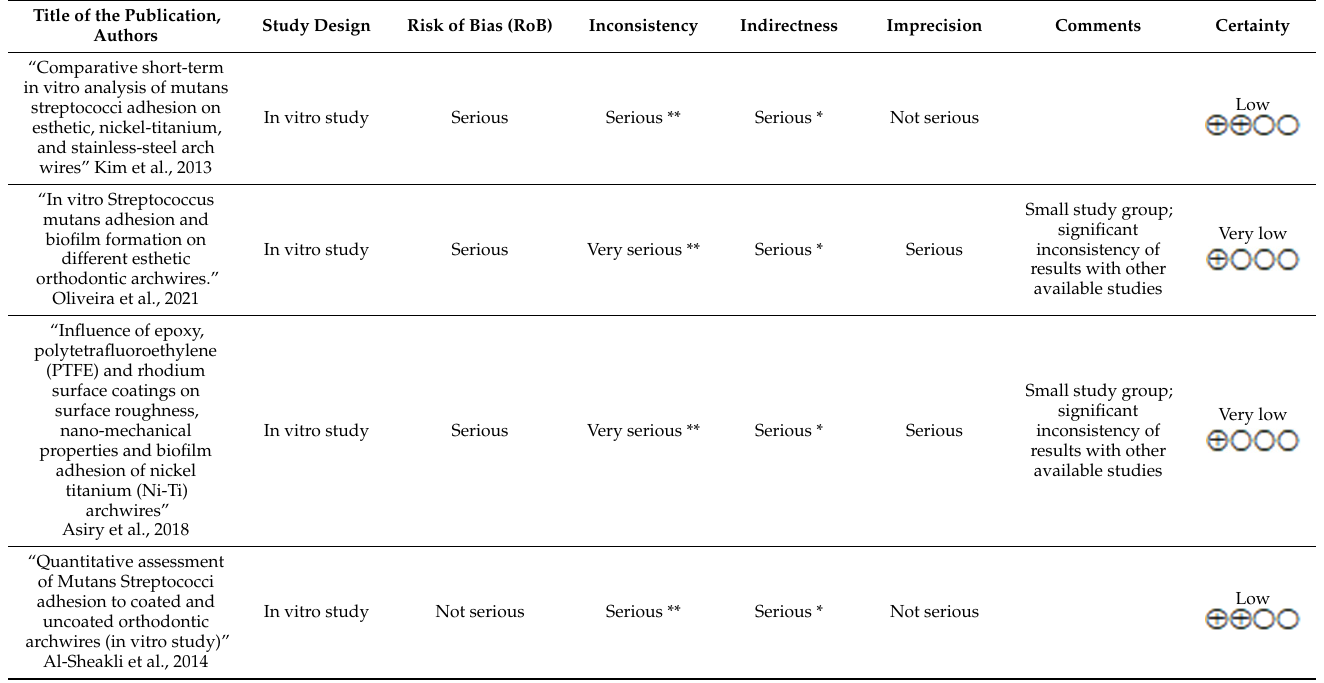
Table 3. The quality analysis of in vitro studies using an individual RoB quality assessment tool created by authors of the systematic review. Table 5. The GRADE analysis for in vitro studies. Table 4. The GRADE analysis for in vivo studies. Table 4. The GRADE analysis for in vivo studies.